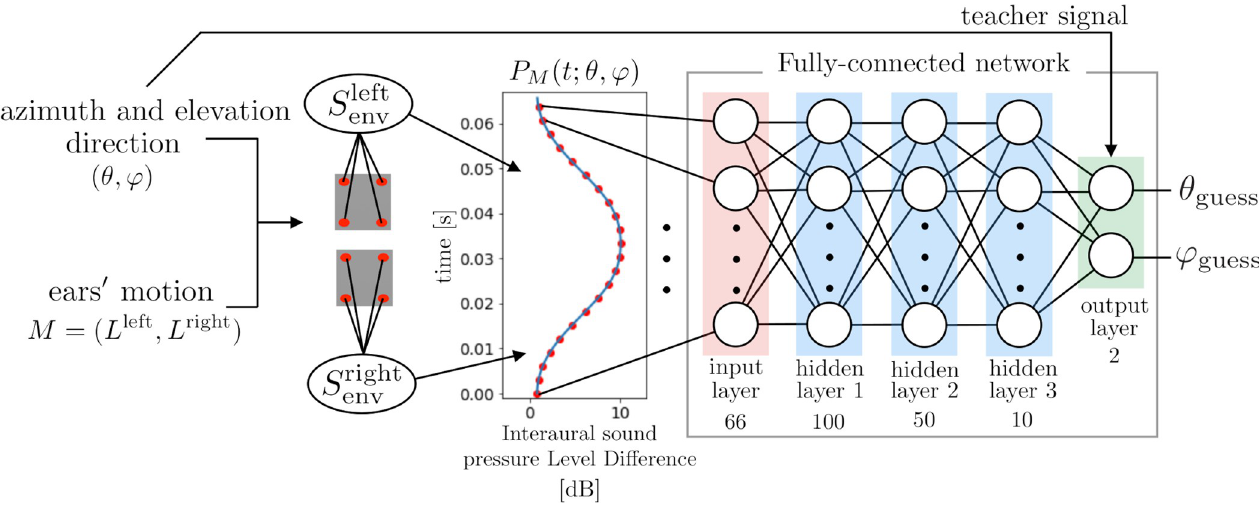
Fig 3. Schematic diagram of the supervised learning approach for obtaining the inverse map of M . The ILD signal is calculated for all directions ( θ , φ ) 2 X fixing the ear motions. It is discretized at time intervals of 1 ms and passed to the input layer of the neural network. In the neural network, the ReLU activation function is used in hidden layers 1, 2, and 3, and the mean squared error is the error function in the output